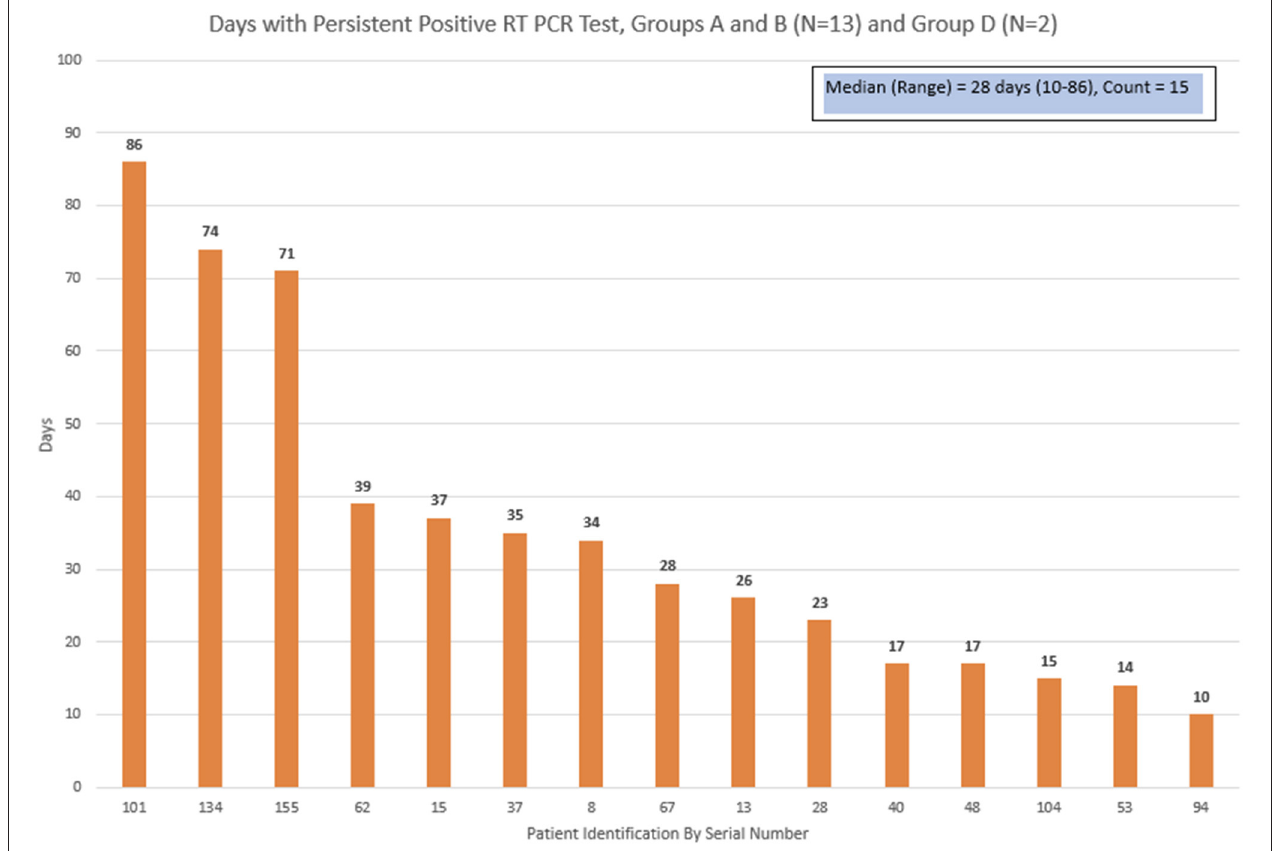
FIGURE 3 | Time kinetics in persistent positivity of COVID PCR